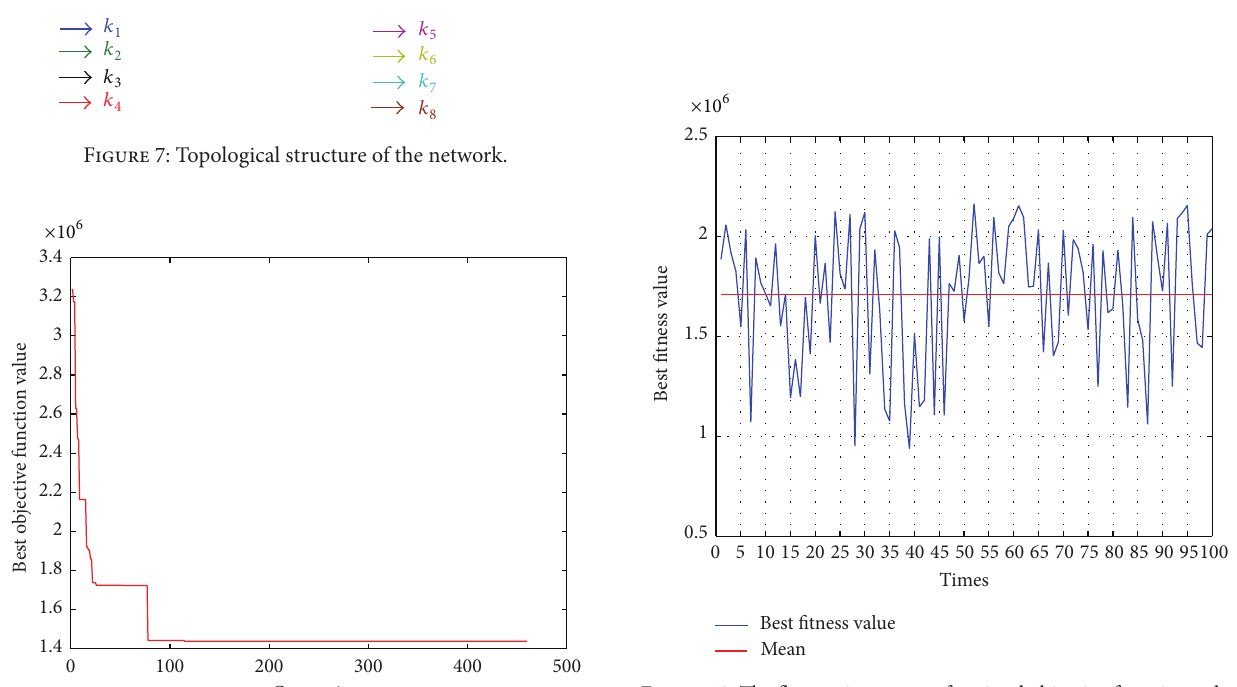
Figure 8: Trends of optimal objective function value by GA.